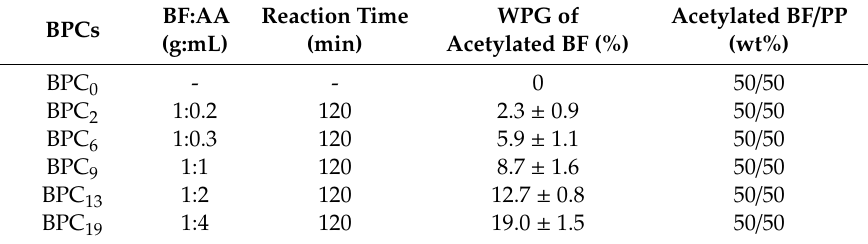
Table 1. Sample code and reaction conditions for di ff erent extents of acetylated